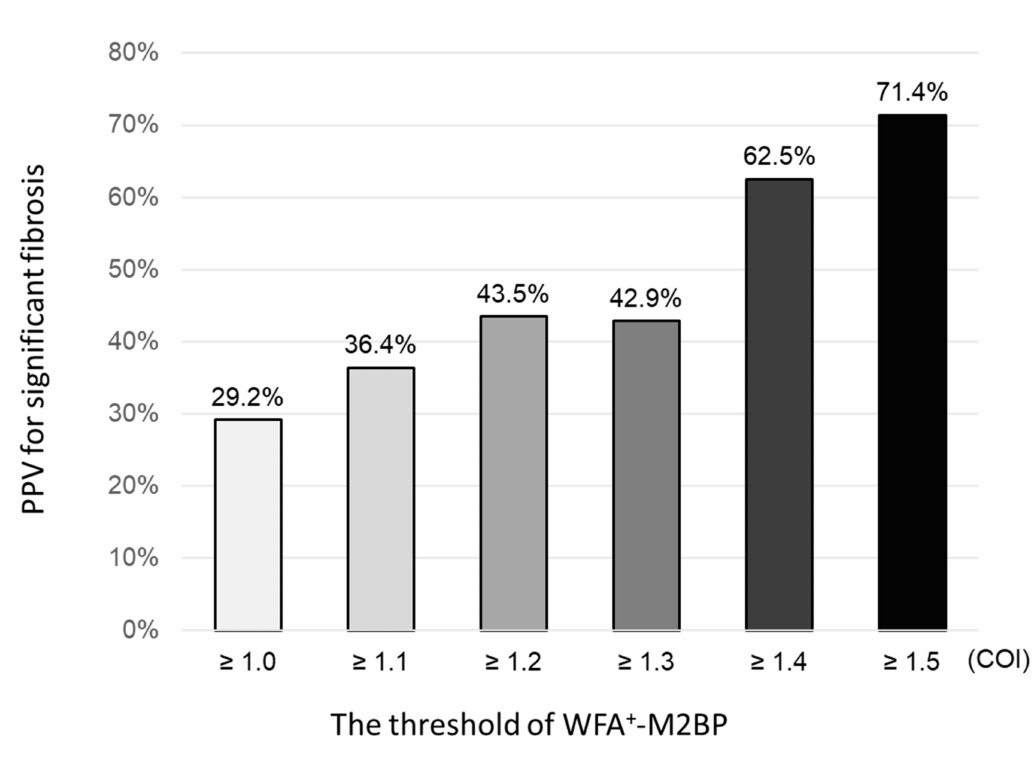
Figure 3. Proportion of significant fibrosis in subjects classified by WFA +